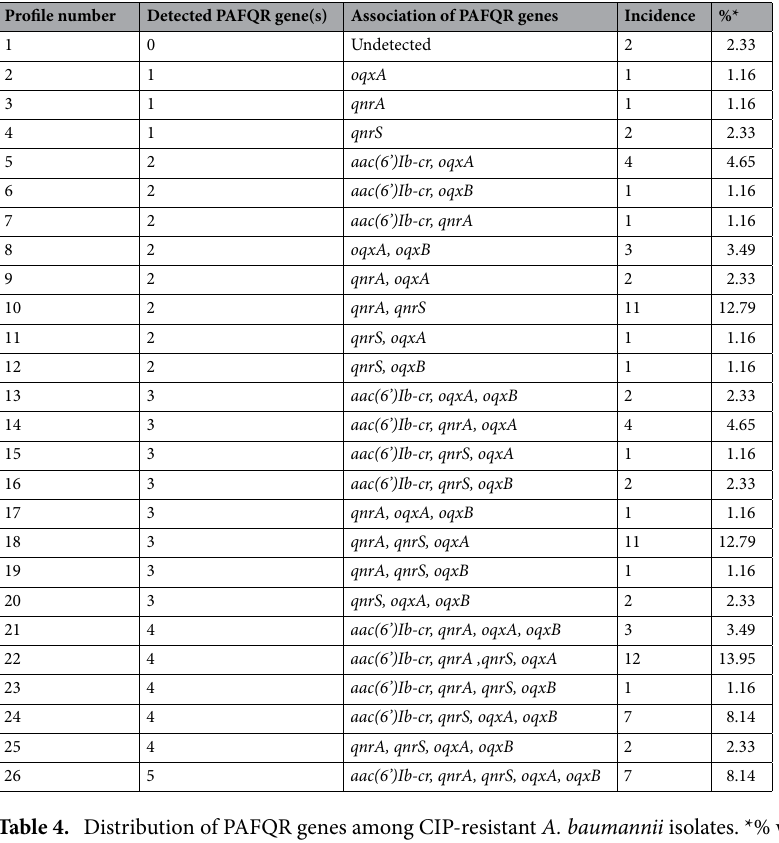
Table 4. Distribution of PAFQR genes among CIP-resistant A. baumannii isolates. *% was calculated relative to total CIP-resistant A. baumannii isolates (n = 86).